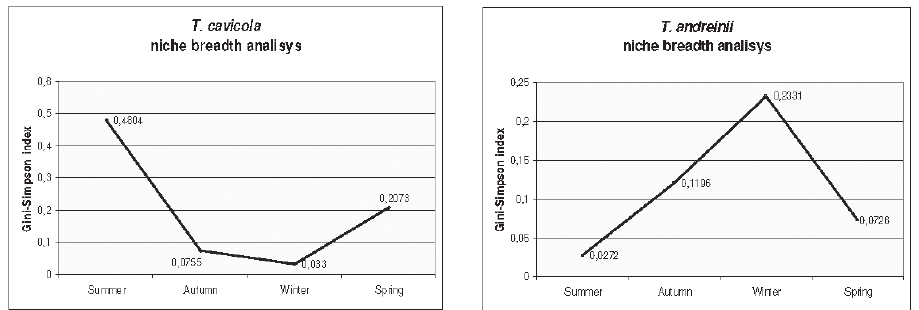
Figure 2. Comparison of seasonal niche breadth in T. cavicola and T. andreinii populations